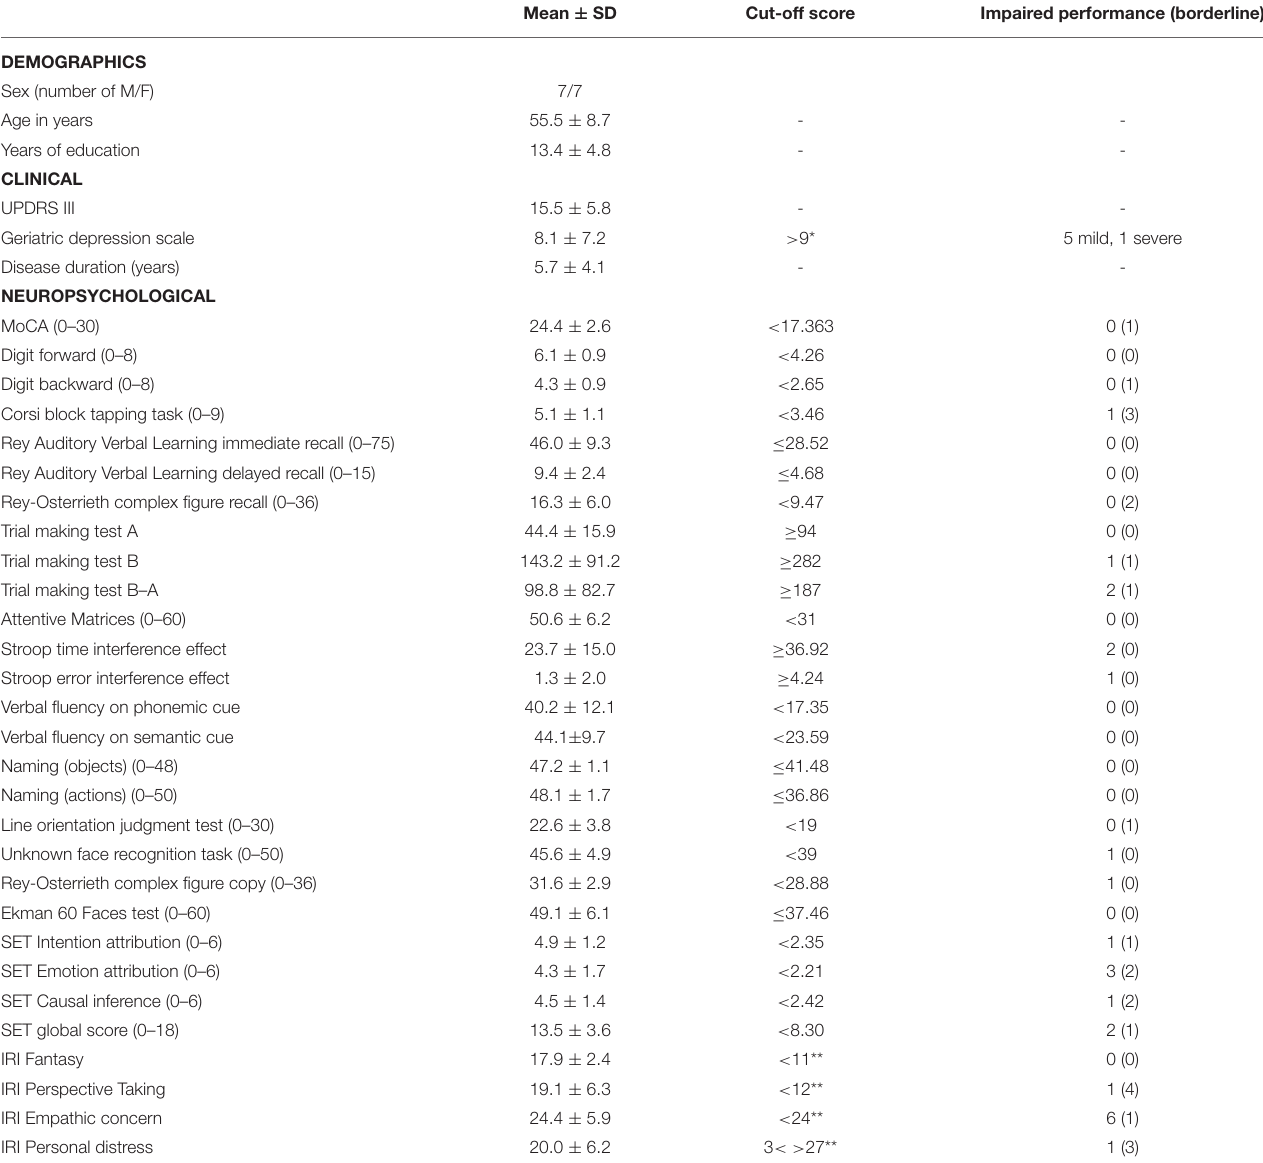
Mean ± SD Cut-off